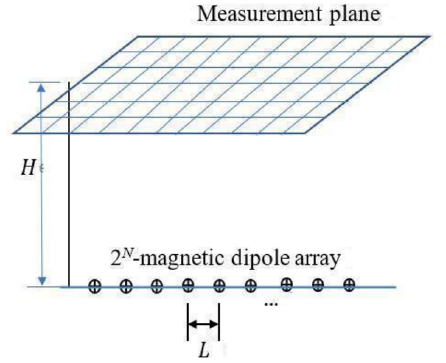
Figure 7. Schematic diagram of the multi-magnetic dipole